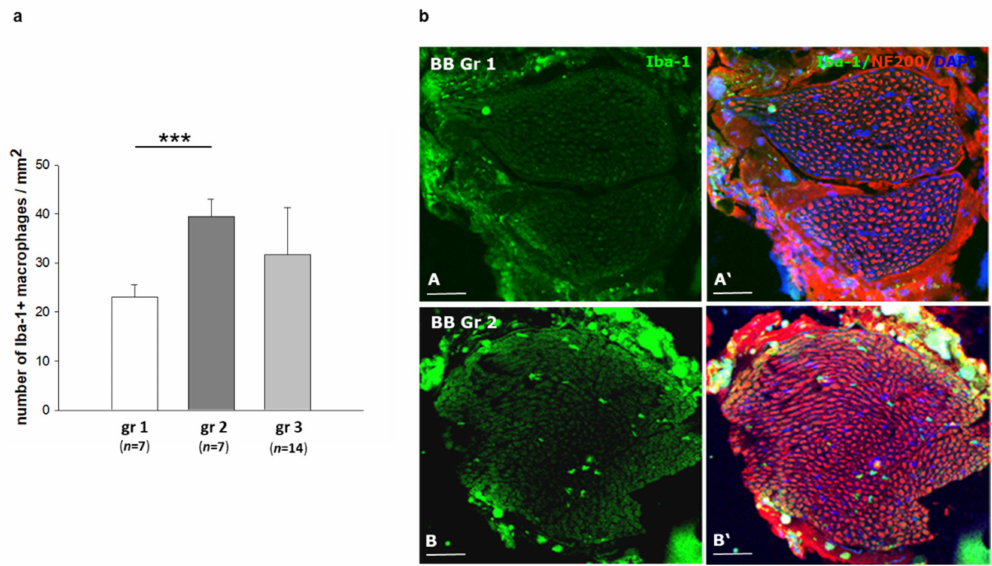
Figure 5. Macrophage distribution in cross sections of sciatic nerves from BB/OKL rats at the end of month 3. ( a ) Quantifica- tion of Iba-1 (ionized calcium binding adaptor molecule 1) —positive macrophages. ( b ) Double IF (immunofluorescence) staining for Iba-1 (green, macrophages) and for neurofilament 200 (red, nerve fibers). Note that immunoreactivity for Iba-1 positive macrophages was higher in sciatic nerves of BB/OKL rats in the group 2 (B) as compared to group 1 (A). Nuclei are stained with DAPI (4 (cid:48) ,6-diamidino-2-phenylindol, blue). Bars represent 100 µ m (AB,A’B’). Data from n = 7 per group are presented as mean ± SEM. *** p ≤ 0.001 according to the one-way analysis of variance together with the Newman–Keuls